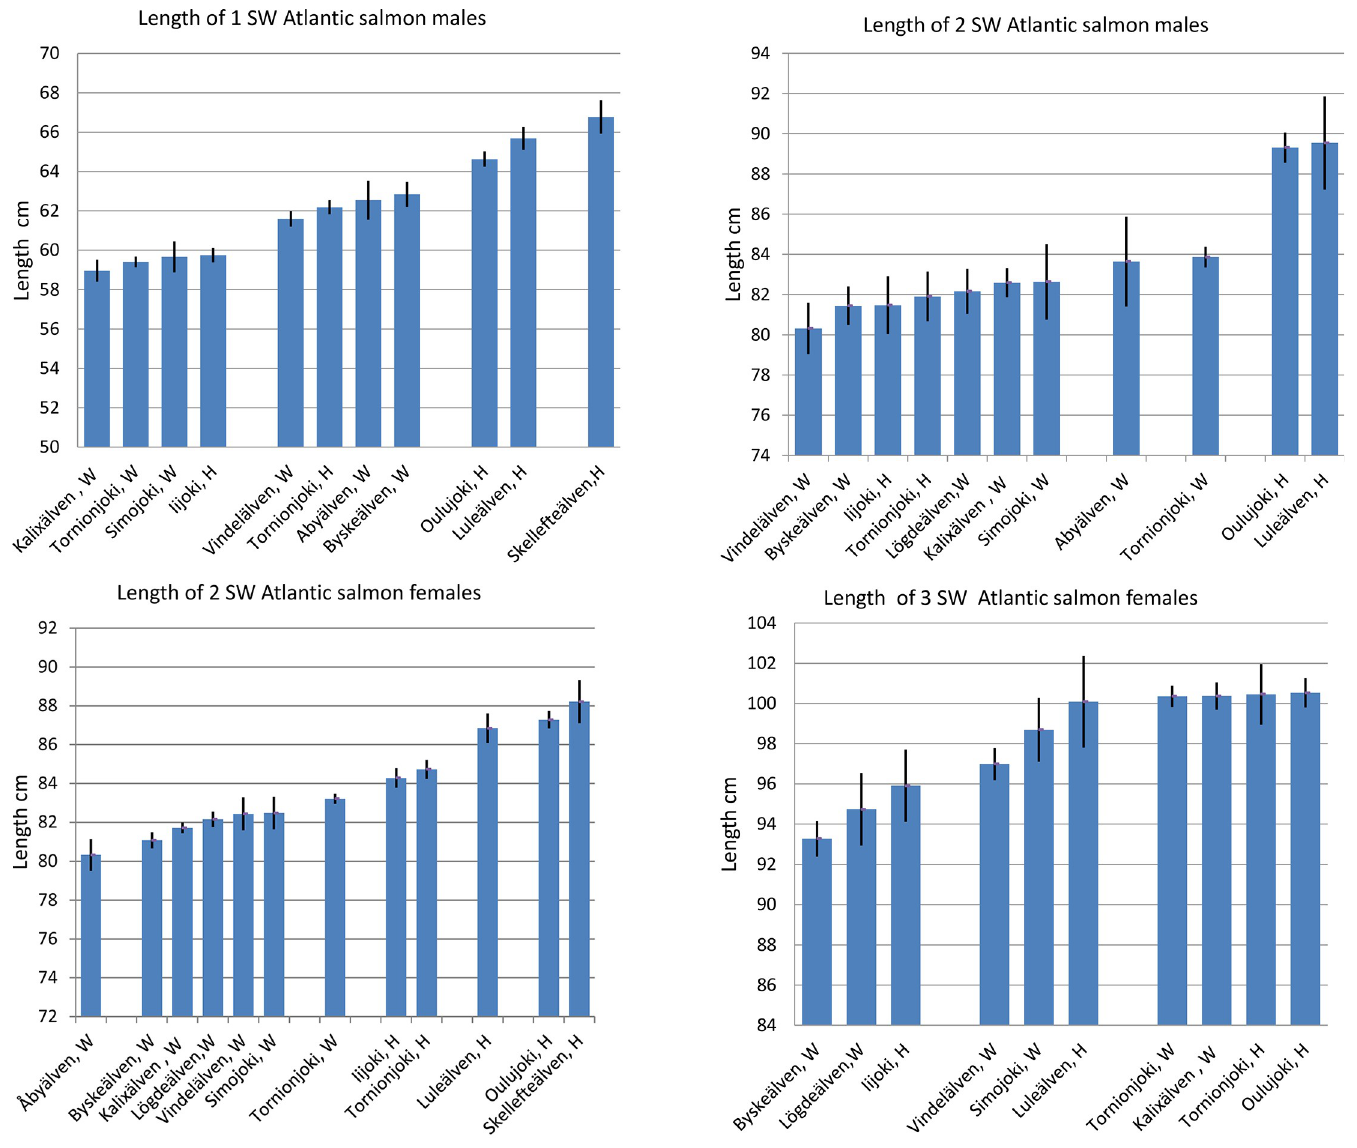
Fig 3. Mean catch length with standard error bars of mature Atlantic salmon aged from 1 to 3 sea-winters in separate river stocks of the Baltic Sea grouped by size classes. A, Mature 1 SW males in catch length classes. B. Mature 2 SW males in catch length classes. C. Mature 2 SW females in catch length classes. D. Mature 3 SW females in catch length classes. There were no statistically significant differences between the smallest and largest means within each size class, but the smallest mean of each size class differed significantly from the smallest mean of the next class. Size classes were based on contrast tests (S4–S6